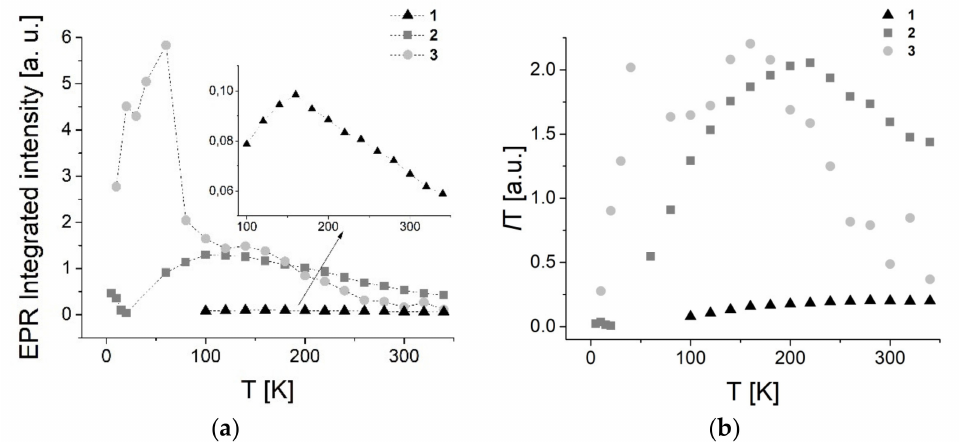
Figure 7. The temperature dependencies of the EPR lines of the integrated intensity I of the whole spectra for all three compounds ( a ), and the IT product ( b ).